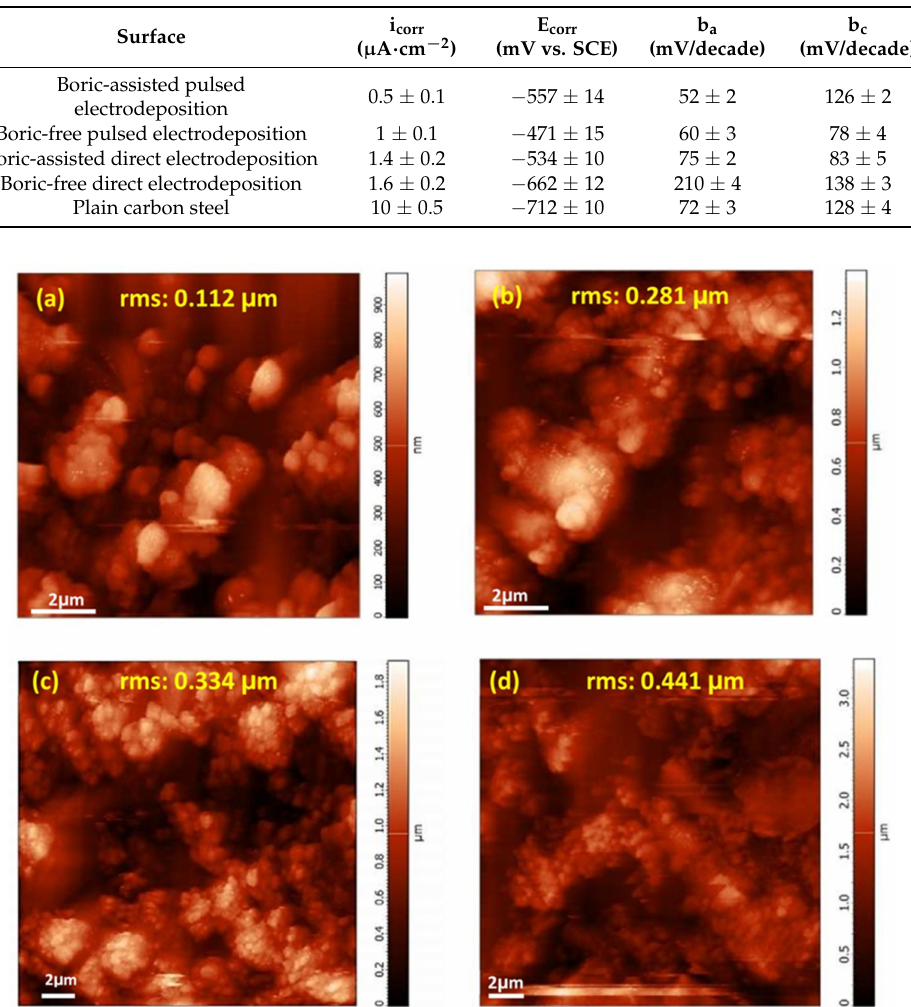
Figure 9. Atomic force microscopy of electrodeposited films; ( a ) boric-free direct electrodeposition, ( b ) boric-assisted direct electrodeposition, ( c ) boric-free pulsed electrodeposition, and ( d ) boric-assisted pulsed